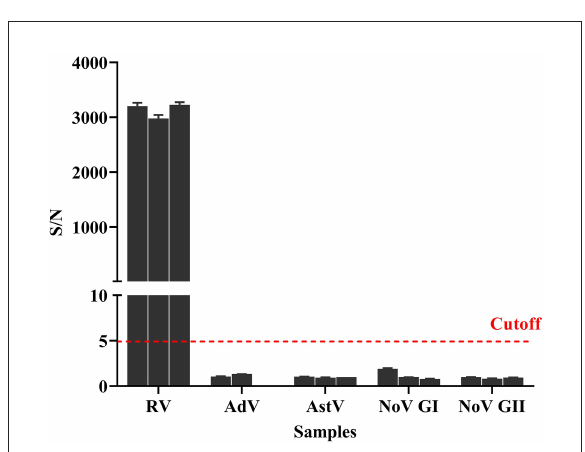
FIGURE5 Cross-reaction of AlphaLISA. Different diarrhea virus-positive samples (3 for RV, 2 for enteric AdV, 3 for AstV, 3 for NoV GI, and 3 for NoV GII) were analyzed with AlphaLISA. The bar represents the standard deviation. The dotted line represents the cutoff value. RV, rotavirus; AdV, adenovirus; AstV, astrovirus; NoV GI, norovirus genogroup I; NoV GII, norovirus genogroup II.